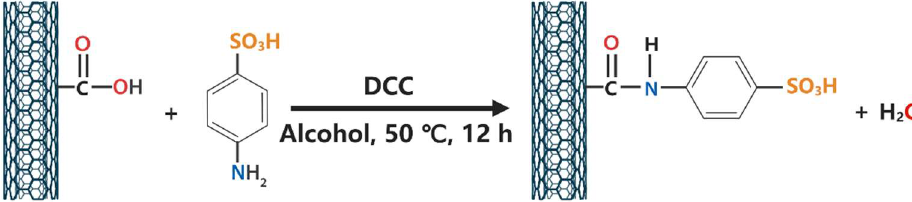
Figure 1. Synthesis procedure of SCNTs.